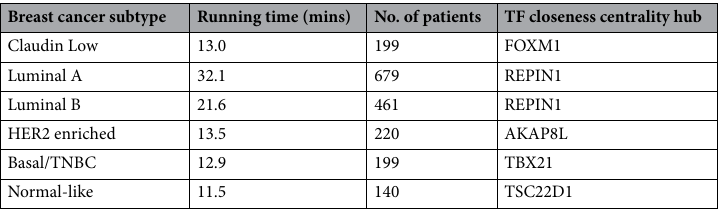
Table 5. METABRIC